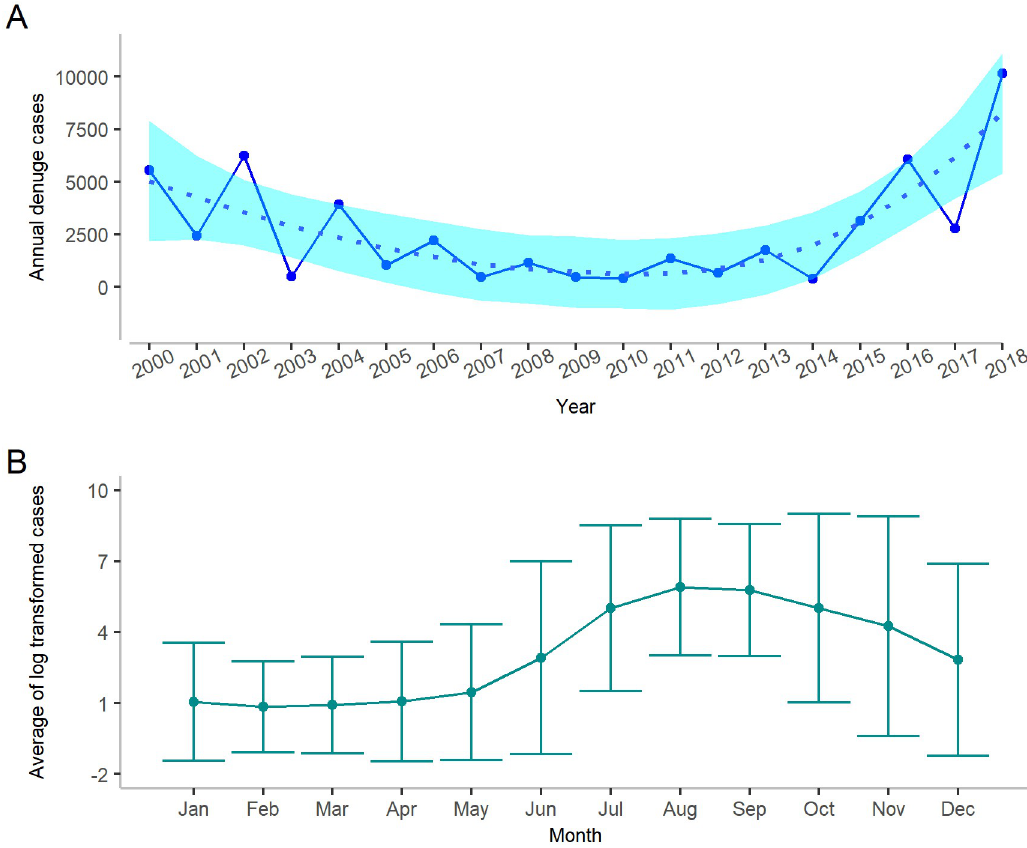
Fig 3. Dengue incidence in Bangladesh for different years and months. ( A ) Annual dengue case trends between 2000 and 2018. A LOESS smoothing function is used to obtain a smooth line to represent the trend over the years. The shaded region shows the pointwise 95% confidence interval. ( B ) Month-wise average dengue cases from January 2000 to December 2018. The shaded area represents the 95% confidence interval.